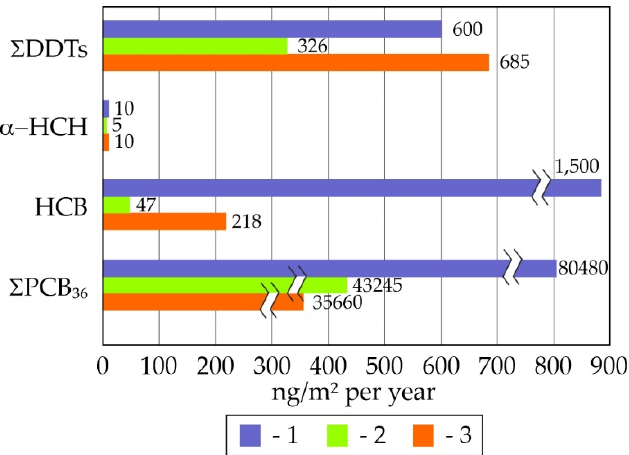
Figure 9. The annual deposition fluxes of organochlorines in Usol’e-Sibirskoe (1), Bolshoe Goloust- noe (2), and Irkutsk (3) (ng/m 2 per year).